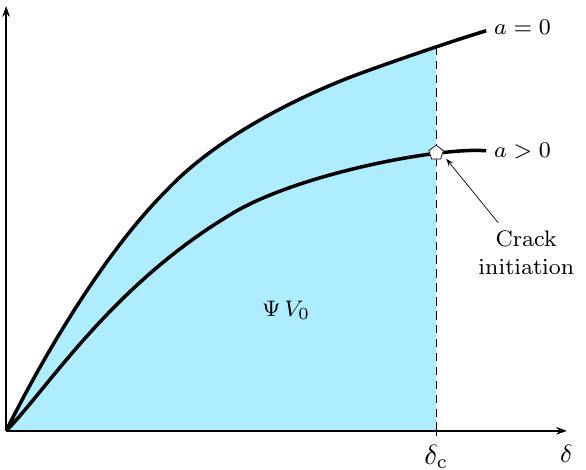
Figure 2. The schematic of the load-displacement curve: the shaded area is the strain energy stored in the uncracked specimen at the critical displacement δ c